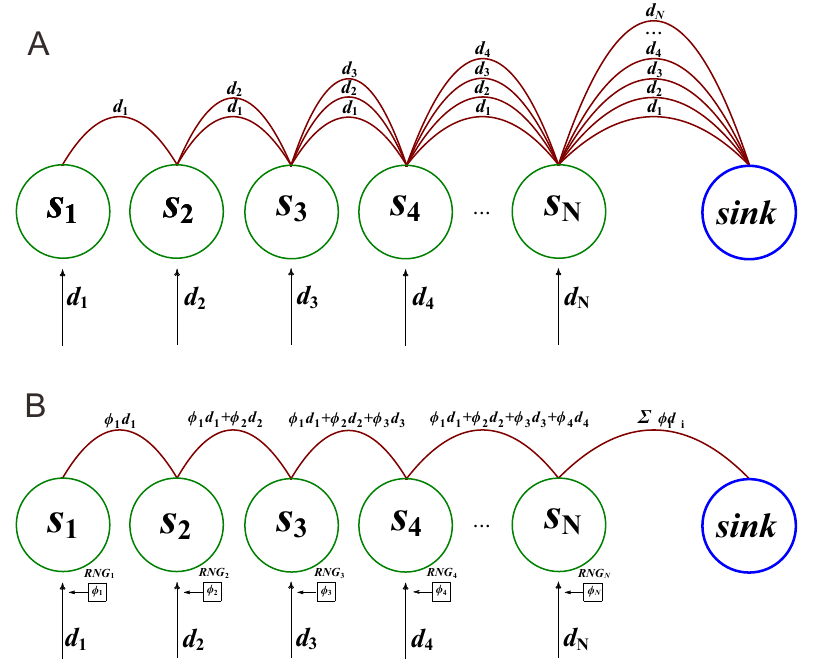
Figure 3. ( A ) Traditional transmitting method of a multi-hop WSN; ( B ) CS method of a multi- hop